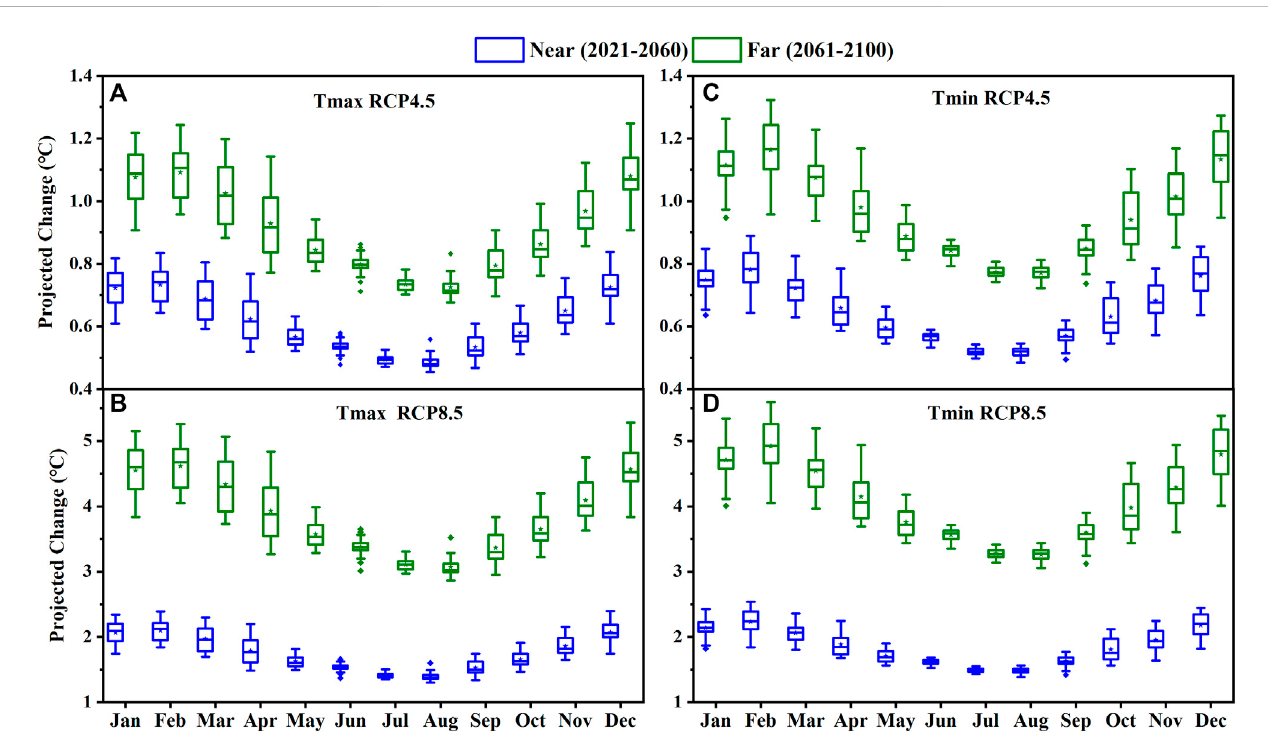
FIGURE 10 Projected changeinaverage monthly Tmax( ° C) andTmin ( ° C)for near (2021 – 2060)and far(2061 – 2100)future periods over Bangladesh for RCP4.5 and RCP8.5. (A) Tmax RCP4.5, (B) Tmax RCP8.5, (C) Tmin RCP4.5, and (D) Tmin